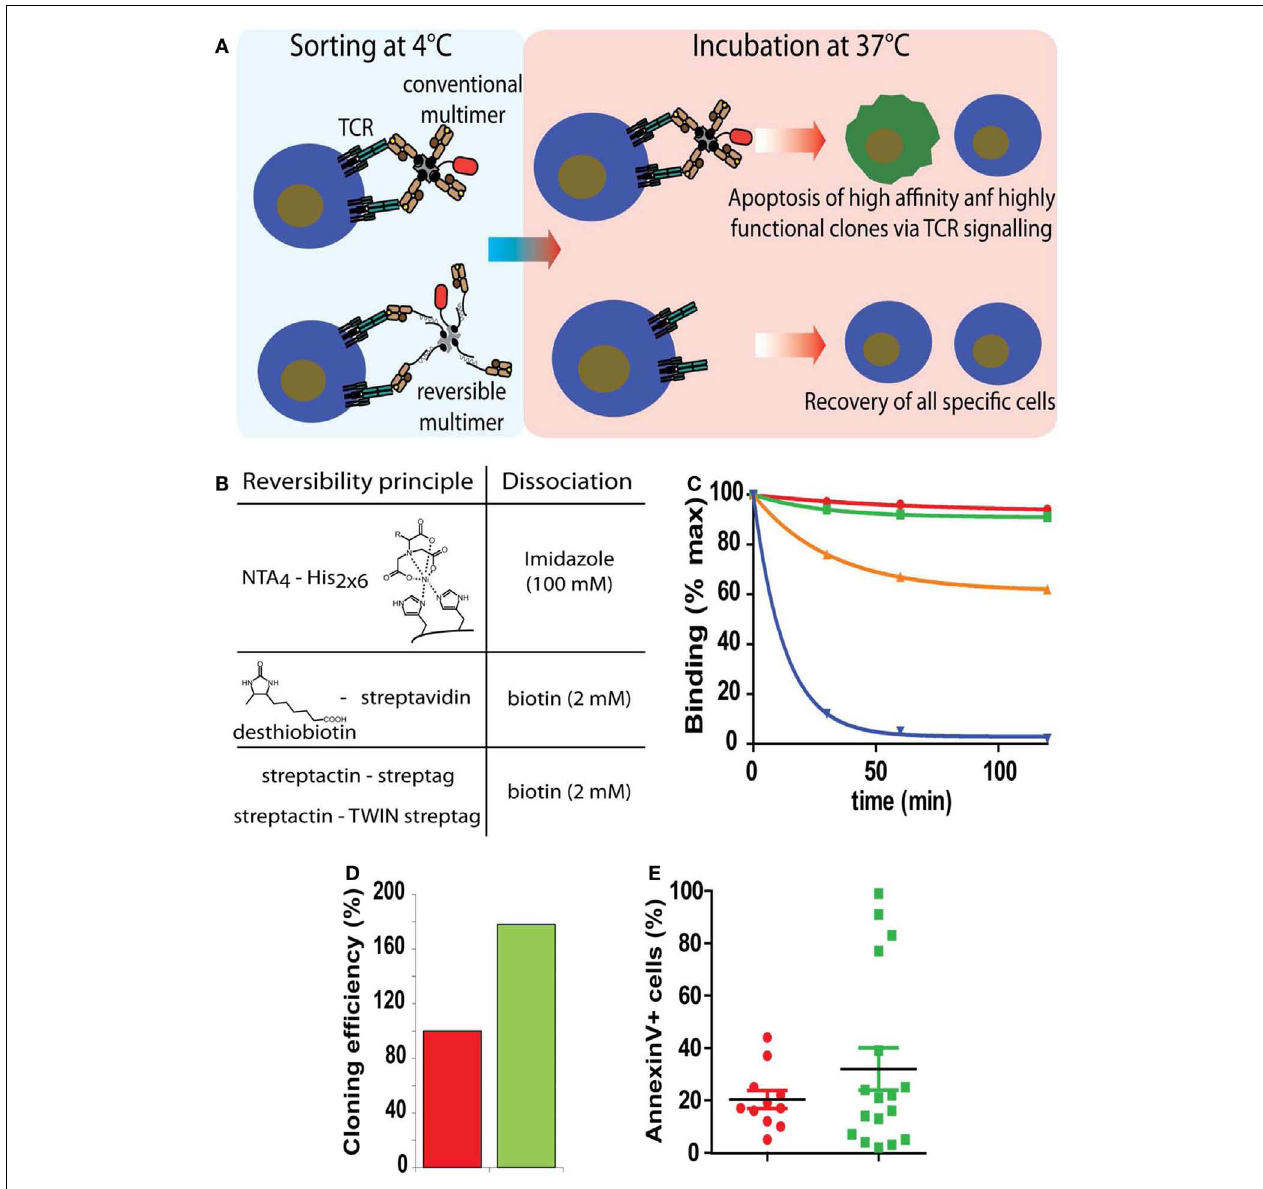
irreversible (red), NTA 4 -His (green), streptactin-streptag (orange), or desthiobiotin–streptavidin (blue) scaffolds, washed and cell-associated fluorescence measured after different periods of incubation at 20°C. (D) Alternatively cells labeled with BSP (red) or NTAmer were FACS sorted and cloned by limiting dilution. Hundred percent refers to the number of clones obtained from BSP multimer sorted cells. (E) Randomly chosen clones were incubated with BSP multimer at 37°C, stained with AnnexinV, and analyzed by flow cytometry. Presented data were derived from